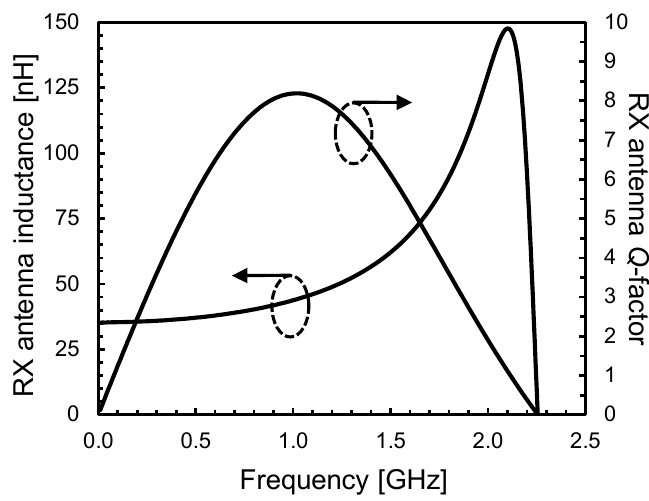
Figure 10. Inductance and Q -factor of the RX antenna as a function of frequency.